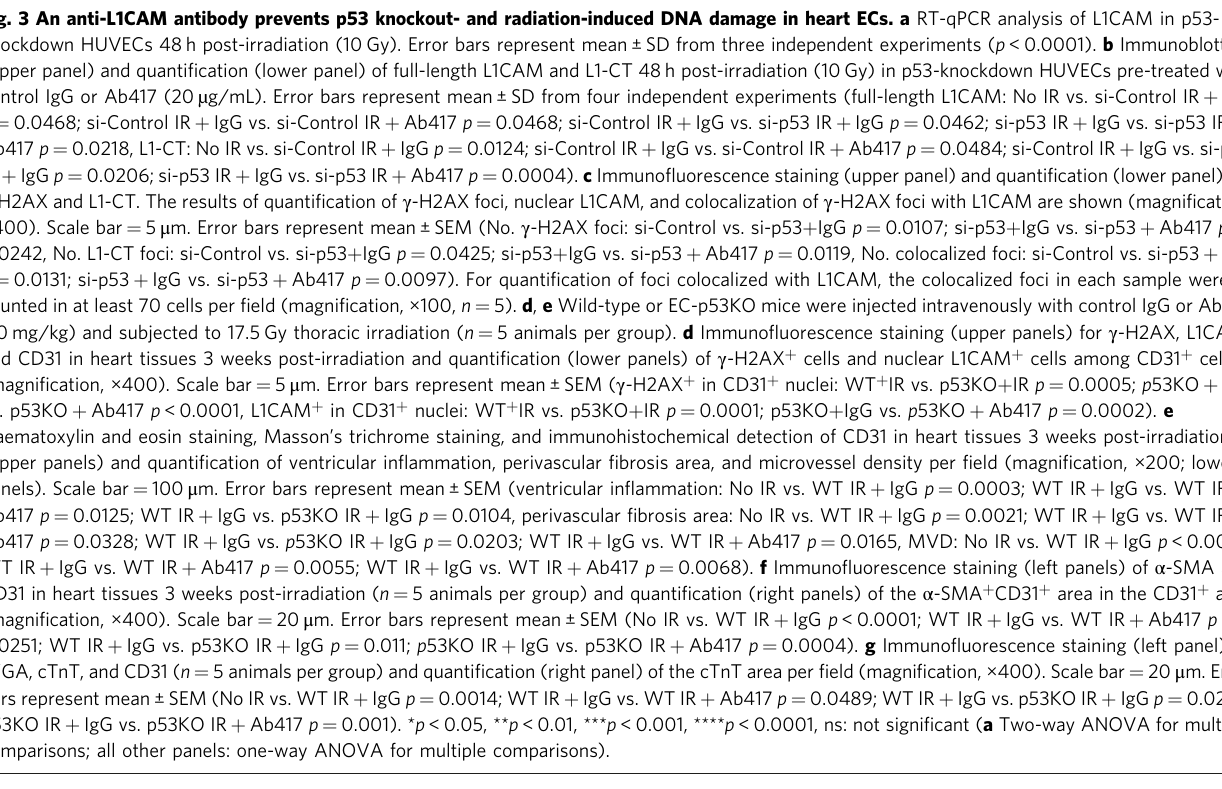
Fig. 3 An anti-L1CAM antibody prevents p53 knockout- and radiation-induced DNA damage in heart ECs. a RT-qPCR analysis of L1CAM in p53- knockdown HUVECs 48 h post-irradiation (10 Gy). Error bars represent mean ± SD from three independent experiments ( p < 0.0001). b Immunoblotting (upper panel) and quanti fi cation (lower panel) of full-length L1CAM and L1-CT 48 h post-irradiation (10 Gy) in p53-knockdown HUVECs pre-treated with control IgG or Ab417 (20 µ g/mL). Error bars represent mean ± SD from four independent experiments (full-length L1CAM: No IR vs. si-Control IR + IgG p = 0.0468; si-Control IR + IgG vs. si-Control IR + Ab417 p = 0.0468; si-Control IR + IgG vs. si-p53 IR + IgG p = 0.0462; si-p53 IR + IgG vs. si-p53 IR + Ab417 p = 0.0218, L1-CT: No IR vs. si-Control IR + IgG p = 0.0124; si-Control IR + IgG vs. si-Control IR + Ab417 p = 0.0484; si-Control IR + IgG vs. si-p53 IR + IgG p = 0.0206; si-p53 IR + IgG vs. si-p53 IR + Ab417 p = 0.0004). c Immuno fl uorescence staining (upper panel) and quanti fi cation (lower panel) for γ -H2AX and L1-CT. The results of quanti fi cation of γ -H2AX foci, nuclear L1CAM, and colocalization of γ -H2AX foci with L1CAM are shown (magni fi cation, ×400). Scale bar = 5 μ m. Error bars represent mean ± SEM (No. γ -H2AX foci: si-Control vs. si-p53 + IgG p = 0.0107; si-p53 + IgG vs. si-p53 + Ab417 p = 0.0242, No. L1-CT foci: si-Control vs. si-p53 + IgG p = 0.0425; si-p53 + IgG vs. si-p53 + Ab417 p = 0.0119, No. colocalized foci: si-Control vs. si-p53 + IgG p = 0.0131; si-p53 + IgG vs. si-p53 + Ab417 p = 0.0097). For quanti fi cation of foci colocalized with L1CAM, the colocalized foci in each sample were counted in at least 70 cells per fi eld (magni fi cation, ×100, n = 5). d , e Wild-type or EC-p53KO mice were injected intravenously with control IgG or Ab417 (10 mg/kg) and subjected to 17.5 Gy thoracic irradiation ( n = 5 animals per group). d Immuno fl uorescence staining (upper panels) for γ -H2AX, L1CAM, and CD31 in heart tissues 3 weeks post-irradiation and quanti fi cation (lower panels) of γ -H2AX + cells and nuclear L1CAM + cells among CD31 + cells (magni fi cation, ×400). Scale bar = 5 μ m. Error bars represent mean ± SEM ( γ -H2AX + in CD31 + nuclei: WT + IR vs. p53KO + IR p = 0.0005; p 53KO + IgG vs. p53KO + Ab417 p < 0.0001, L1CAM + in CD31 + nuclei: WT + IR vs. p53KO + IR p = 0.0001; p53KO + IgG vs. p 53KO + Ab417 p = 0.0002). e Haematoxylin and eosin staining, Masson ’ s trichrome staining, and immunohistochemical detection of CD31 in heart tissues 3 weeks post-irradiation (upper panels) and quanti fi cation of ventricular in fl ammation, perivascular fi brosis area, and microvessel density per fi eld (magni fi cation, ×200; lower panels). Scale bar = 100 μ m. Error bars represent mean ± SEM (ventricular in fl ammation: No IR vs. WT IR + IgG p = 0.0003; WT IR + IgG vs. WT IR + Ab417 p = 0.0125; WT IR + IgG vs. p53KO IR + IgG p = 0.0104, perivascular fi brosis area: No IR vs. WT IR + IgG p = 0.0021; WT IR + IgG vs. WT IR + Ab417 p = 0.0328; WT IR + IgG vs. p 53KO IR + IgG p = 0.0203; WT IR + IgG vs. WT IR + Ab417 p = 0.0165, MVD: No IR vs. WT IR + IgG p < 0.0001; WT IR + IgG vs. WT IR + Ab417 p = 0.0055; WT IR + IgG vs. WT IR + Ab417 p = 0.0068). f Immuno fl uorescence staining (left panels) of α -SMA and CD31 in heart tissues 3 weeks post-irradiation ( n = 5 animals per group) and quanti fi cation (right panels) of the α -SMA + CD31 + area in the CD31 + area (magni fi cation, ×400). Scale bar = 20 μ m. Error bars represent mean ± SEM (No IR vs. WT IR + IgG p < 0.0001; WT IR + IgG vs. WT IR + Ab417 p = 0.0251; WT IR + IgG vs. p53KO IR + IgG p = 0.011; p 53KO IR + IgG vs. p53KO IR + Ab417 p = 0.0004). g Immuno fl uorescence staining (left panel) of WGA, cTnT, and CD31 ( n = 5 animals per group) and quanti fi cation (right panel) of the cTnT area per fi eld (magni fi cation, ×400). Scale bar = 20 μ m. Error bars represent mean ± SEM (No IR vs. WT IR + IgG p = 0.0014; WT IR + IgG vs. WT IR + Ab417 p = 0.0489; WT IR + IgG vs. p53KO IR + IgG p = 0.0253; p53KO IR + IgG vs. p53KO IR + Ab417 p = 0.001). * p < 0.05, ** p < 0.01, *** p < 0.001, **** p < 0.0001, ns: not signi fi cant ( a Two-way ANOVA for multiple comparisons; all other panels: one-way ANOVA for multiple